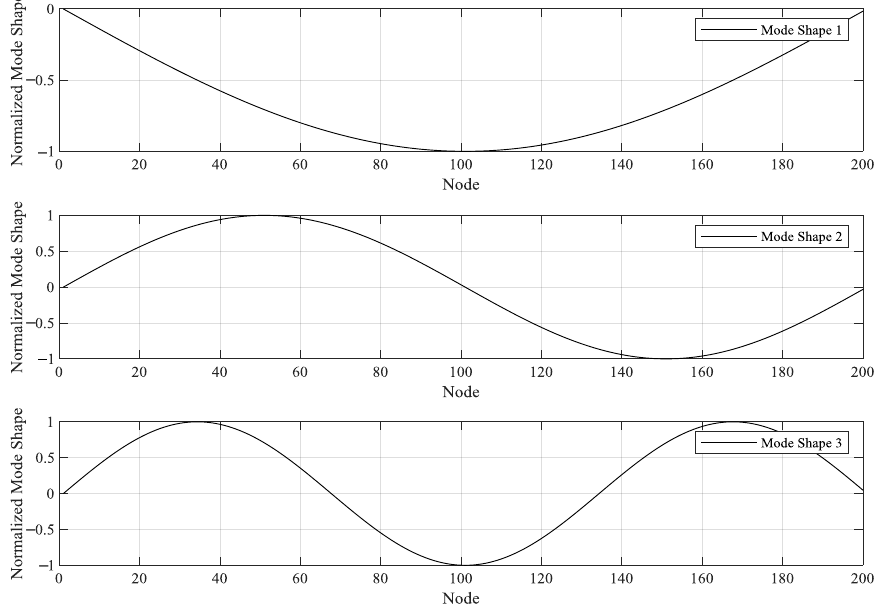
Figure 19. The first three mode shapes of a numerical bridge. Table 10. Damage case for a numerical bridge.